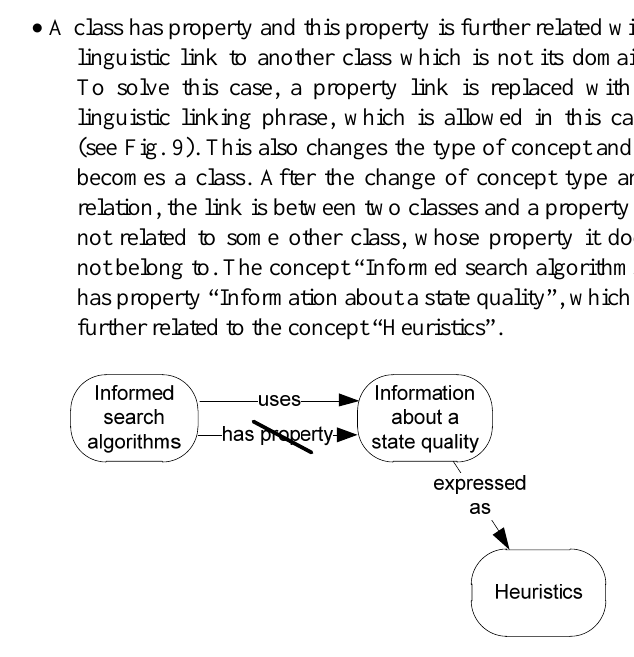
Fig. 9. An example of a property related to two classes